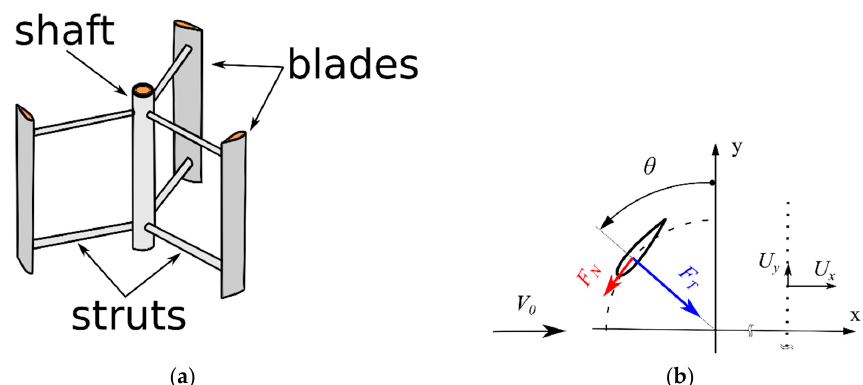
Figure 1. H-Darrieus wind turbine rotor and analyzed quantities. ( a ) Silhouette of the H-type Darrieus wind turbine; ( b ) Aerodynamic forces acting on the wind turbine blade and velocity components in the aerodynamic wake downstream behind the